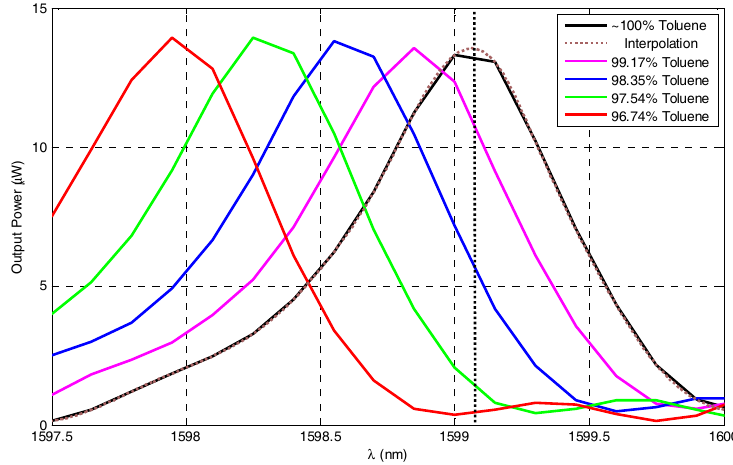
Figure 10. Zooming of the output power in μ W versus wavelength in nm around the selected peak for refractometry analysis.